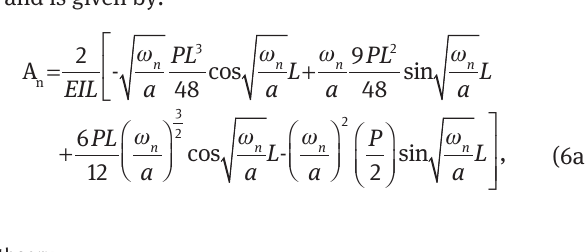
Table 1: Data used to obtain frequency for cantilever beam in classical theory.